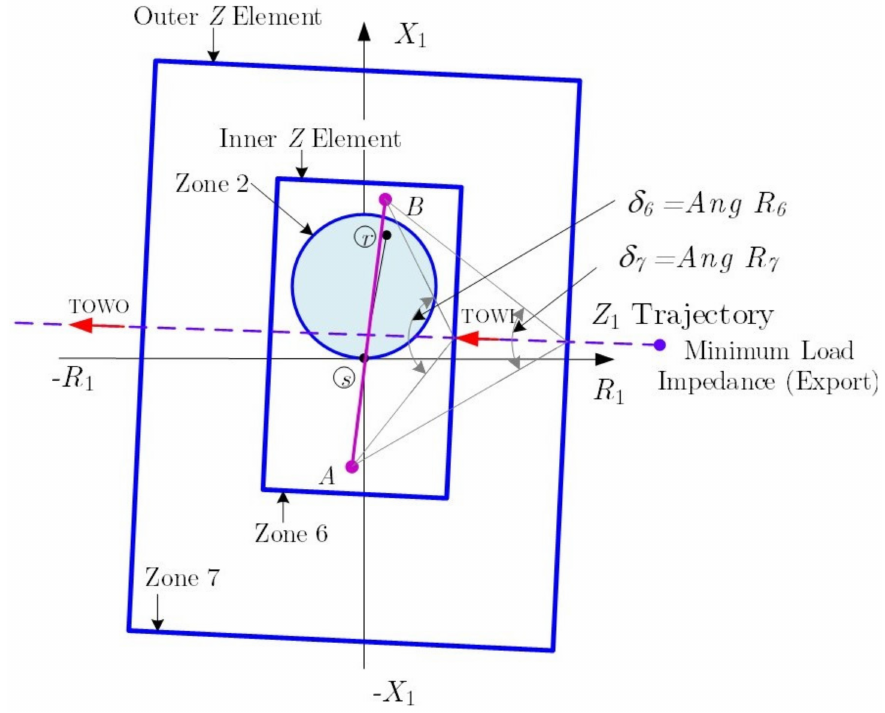
Figure 11. Out of step Characteristics used to calculate the OOS tripping setting. The positive sequence impedance ( Z 1 ) trajectory of the power swing defines the Zone 6 and Zone 7 settings for the OST logic depend